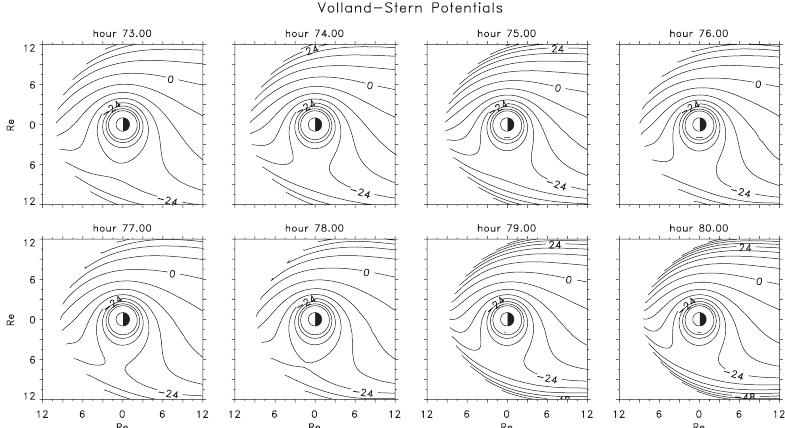
Fig. 2. Electric potential isocontour plots for the Volland-Stern electric field model at 8 times during the main phase of the 4 May 1998 storm. Contours are shown every 6kV, and are not drawn inside of 2 R E or beyond the magnetopause, as specified in the model. Note that corotation is included in the potential pattern.